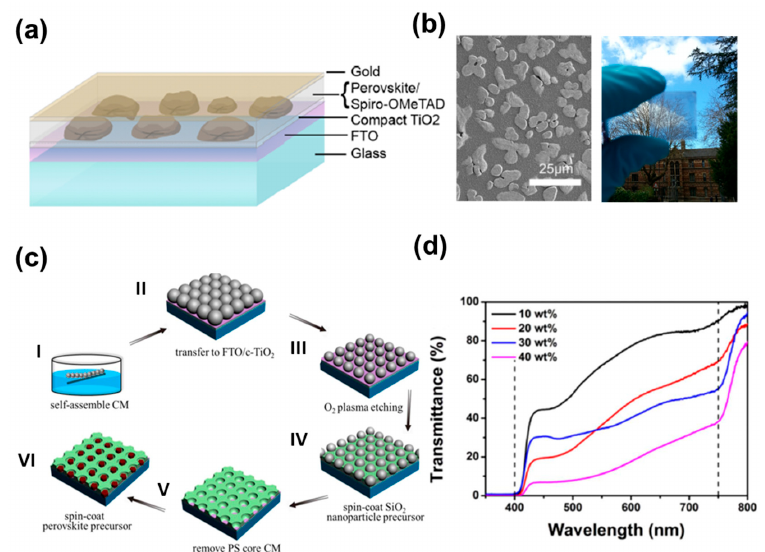
Figure 5. ( a ) Schematic representation of cells fabricated with dewetted region in planar perovskite heterojunction solar cells ( b ) FESEM and digital images of ST-PSC. ( c ) Schematic representation for the fabrication process for SiO 2 HC structure patterned perovskite layer. ( d ) Transmittance spectra for these active layers of perovskite films. Reprinted with permission from refs.